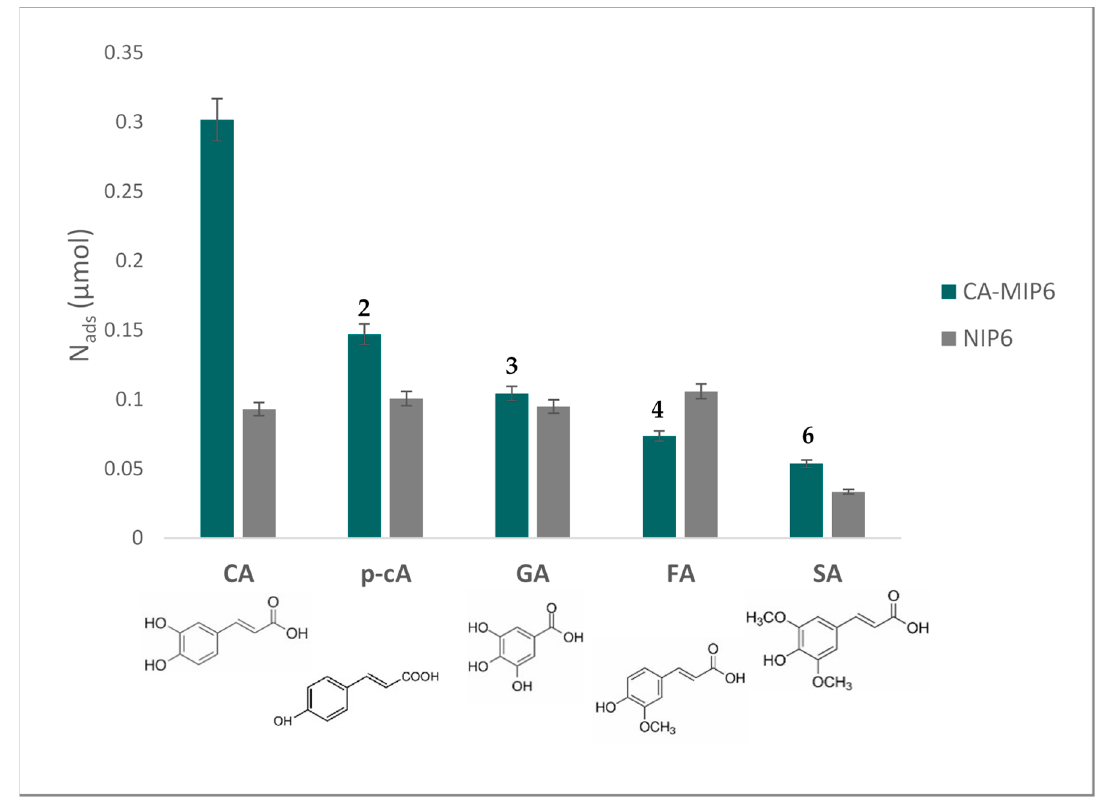
Figure 5. N ads (mol number adsorbed on MIP6 and NIP6. Rebinding tests were done in a PBS/EtOH solution (PBS/EtOH, 90/10, v / v ). Concentration of competing antioxidants = 0.55 mM, polymer mass = 10 mg. CA: caffeic acid, p-cA: p-coumaric acid, GA: gallic acid, FA: ferulic acid, SA: sinapic acid. The number above the MIP bars represents the selectivity coefficient α